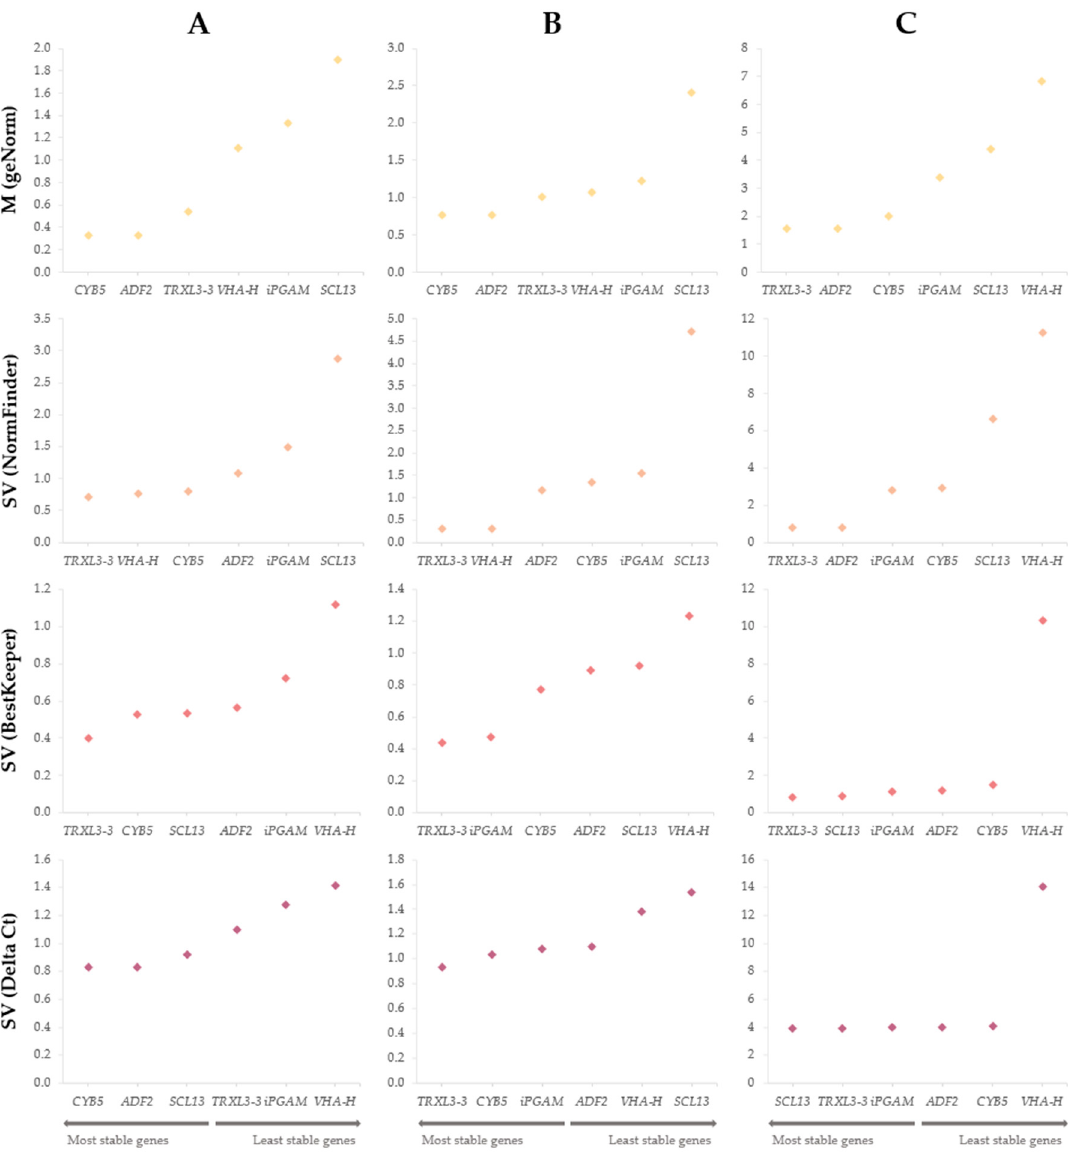
Figure 2. Expression stability of six tested candidate reference genes (RGs) calculated by ( ) geNorm (M), ( ) NormFinder, ( ) BestKeeper, and ( ) Δ Ct (SV) methods in three experiments: ( A ) comparison of leaf colour (green and red) in lettuce commercial varieties; ( B ) comparison of tissues (leaf and stem) in a wild relative species; and ( C ) under drought stress in a commercial variety, a traditional variety, and a wild relative. The most stable genes are represented on the left and the least stable on the right of the graph.